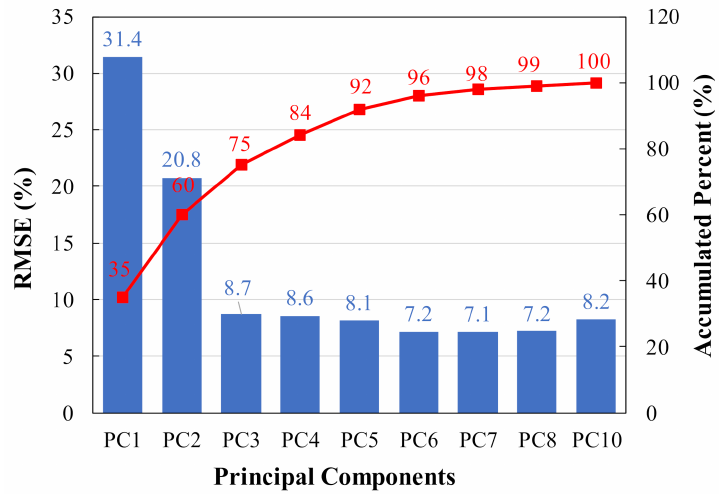
Figure 1. Significance of each principal